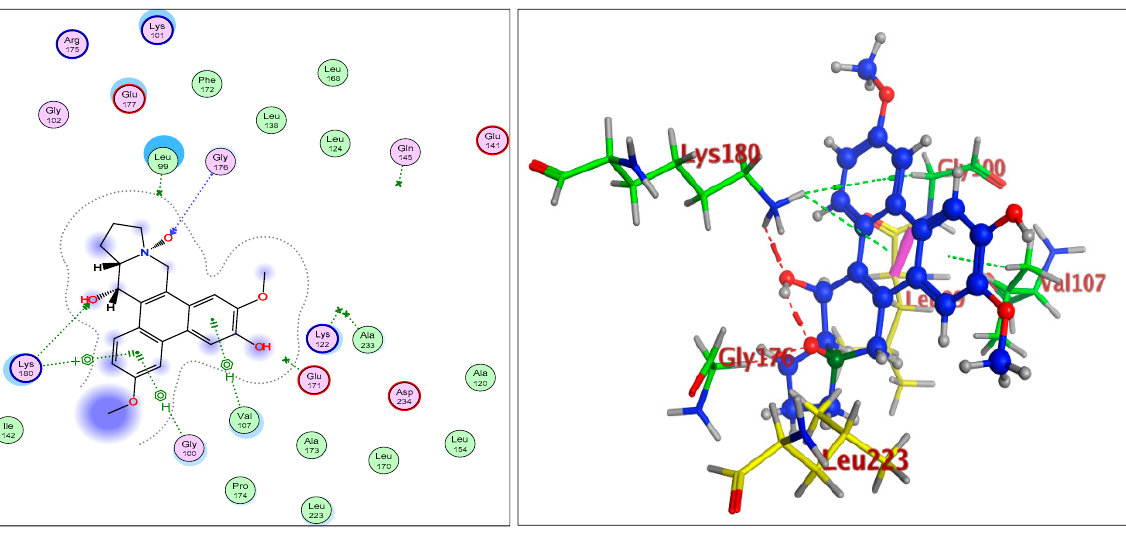
Figure 6. Overlay of compound ( 6 ) bound to the active site of ATP-binding pocket of Aurora-B. Table 3. Radiometric kinase assay * of the isolated compounds from Tylophora indica . Serial